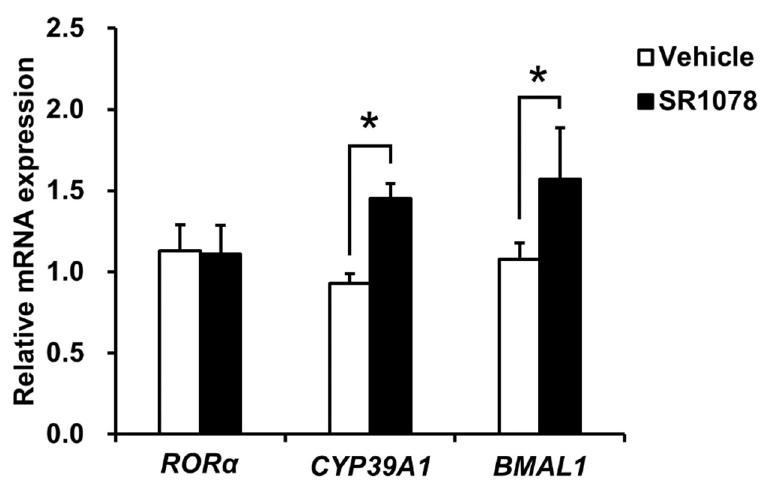
Figure 5. Effect of RORα agonist activation on CYP39A1 expression. HepG2 cells expressing endogenous RORα were treated without (vehicle) or with 5 μM SR1078, a synthetic RORα agonist, for 48 h; RORα, CYP39A1, and BMAL1 gene expression levels were quantified by qRT-PCR. Expression levels of each RORα target gene stimulated by the RORα agonist are presented as fold-changes relative to changes induced by vehicle alone. Data are presented as means ± standard error of the means ( n = 3). *, p < 0.05.